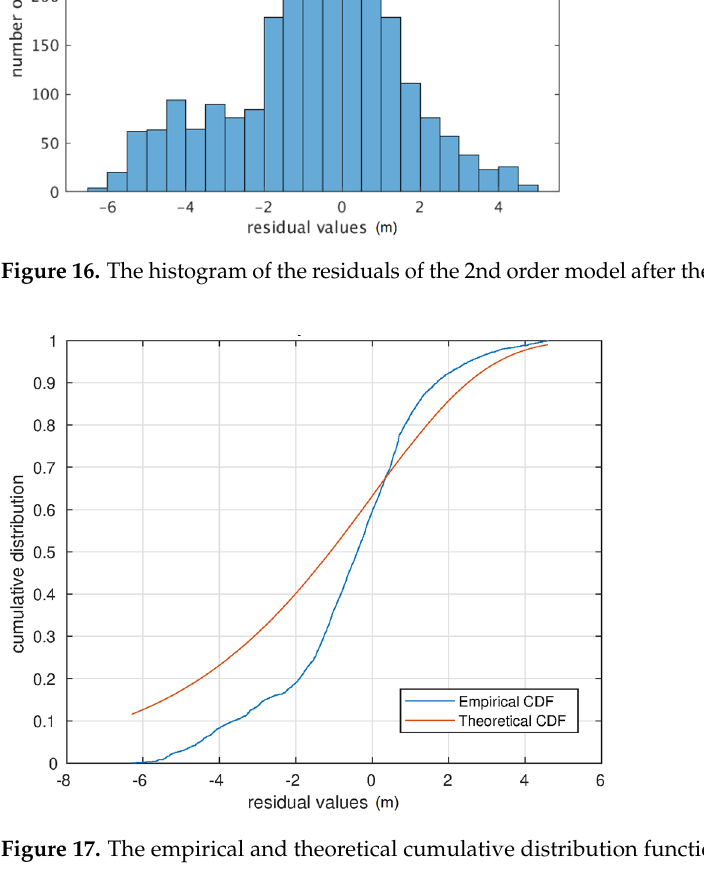
Table 5. Descriptive statistics for relative residuals of 2nd order bathymetric corrector surface fit.